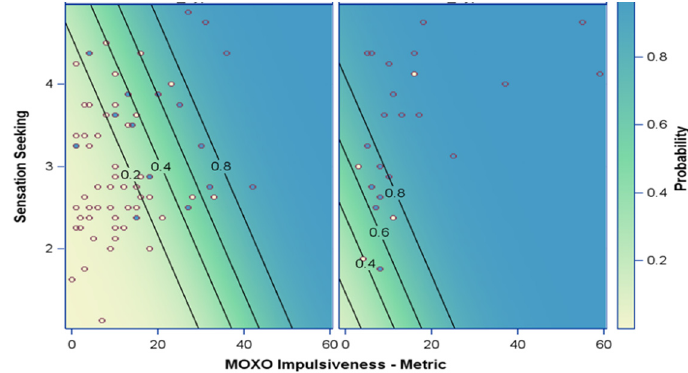
Figure 2. Risk index for SUD. The probability index for SUD takes into account the BSSS-Total score and the MOXO-CPT Impulsivity Index, differentiating between persons with and without SMD-SOR. SMD-SOR, sensory over-responsivity; MOXO-CPT, MOXO continuous performance test; SUD, substance use disorder.